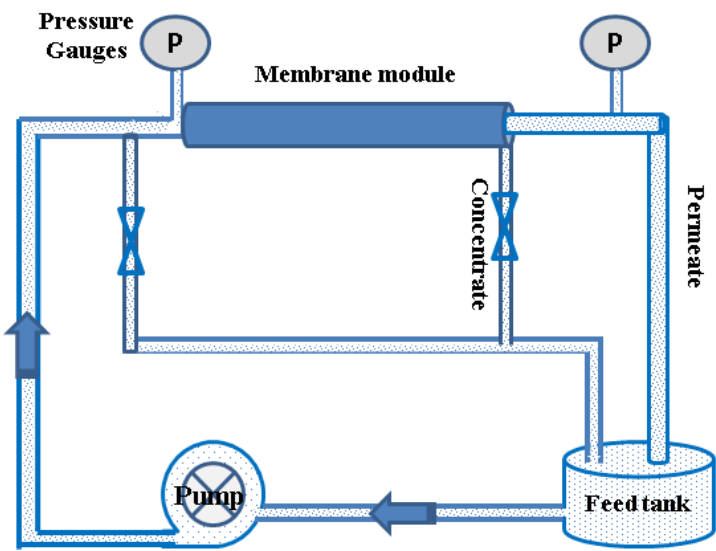
Figure 1. Schematic representation of the NF system.